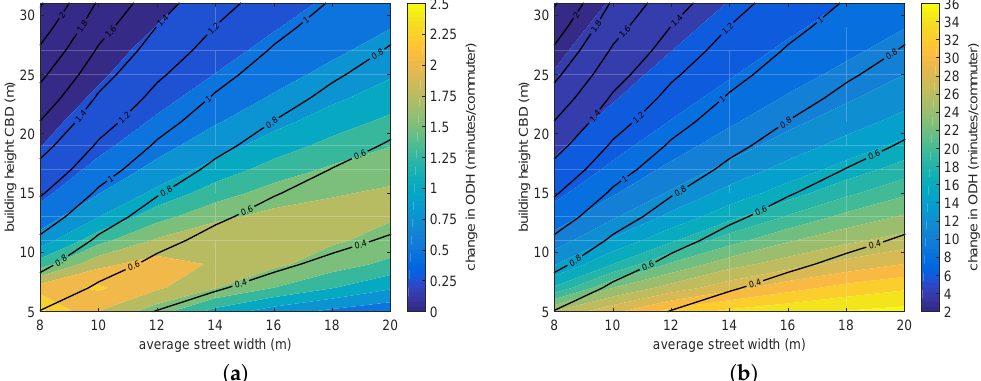
Figure 13. Difference in the time exposed to heat stress ( ODH ) as a function of W and H CBD ( a ) for simulations with A 0 W = 0.6 minus A 0 W = 0.1 ( A 0 S is set to 0.15); and ( b ) A 0 W = A 0 S = 0.6 minus A 0 W = A 0 S = 0.1. Please note the different scaling of both